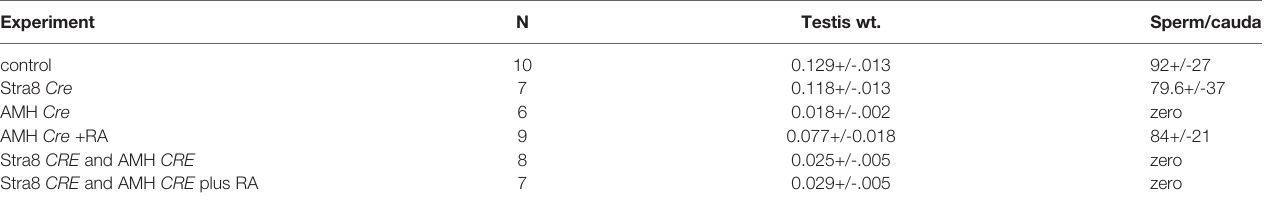
In some experiments (4 and 6) mice were treated with RA and analyzed 4 weeks later to determine if spermatogenesis could recover. N is number of individual mice. Values plus standard deviation are shown.